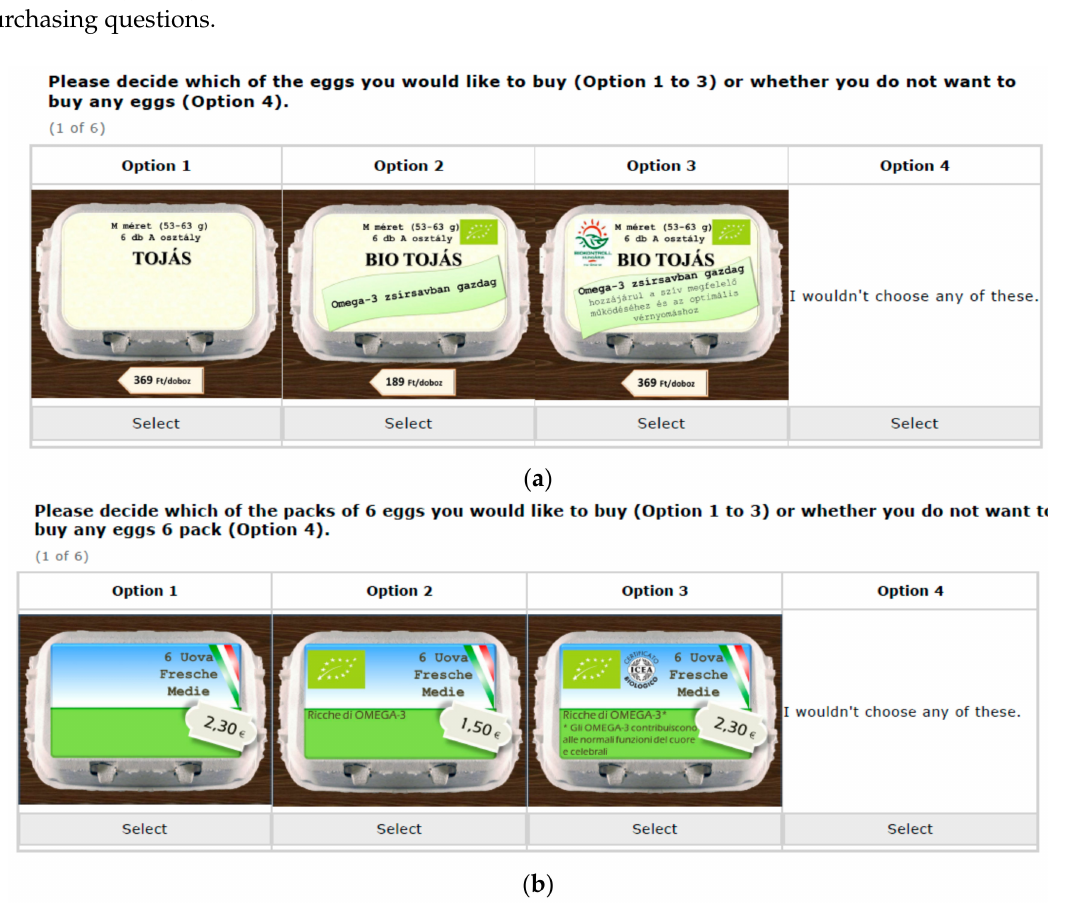
Figure 1. ( a ) An example of Hungarian discrete choice experiment (DCE) question. ( b ). An example of Italian DCE